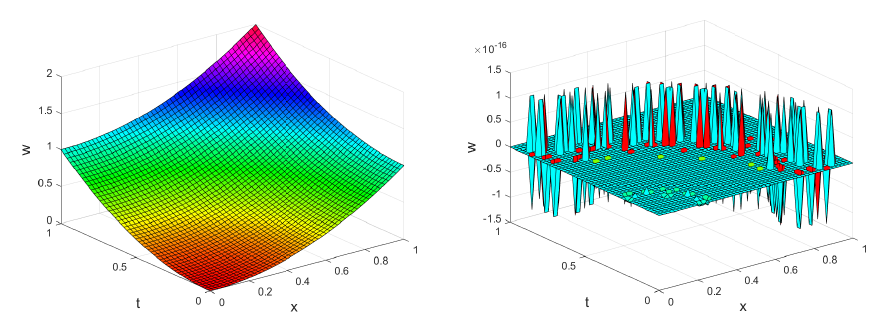
Figure 1. Approximate solution ( left ) and corresponding absolute errors ( right ), with m = 3 and β = 0.4, for Example 1.